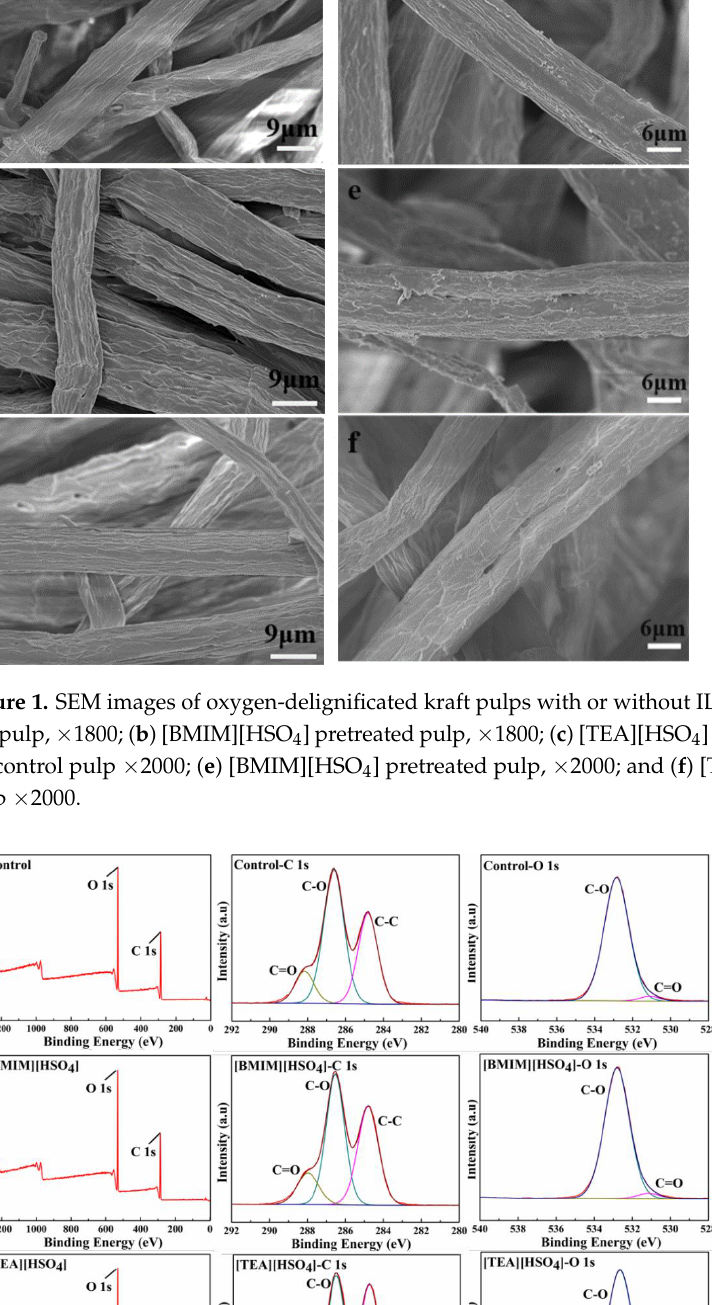
Figure 2. XPS analysis of oxygen-delignificated kraft pulps with or without IL pretreatments.